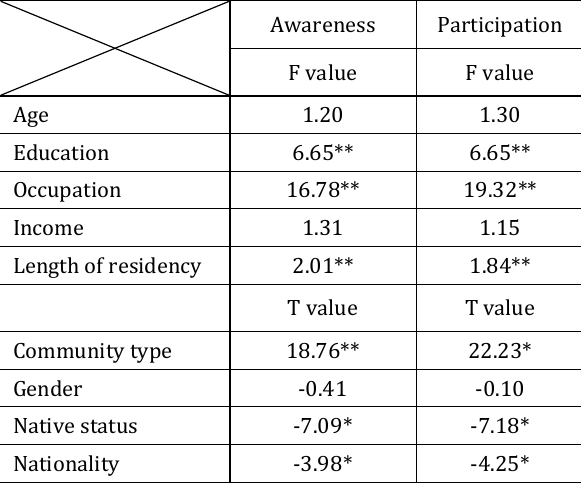
Table 3. Differences in ecotourism awareness and participation based on socio-demographic characteristics of respondents